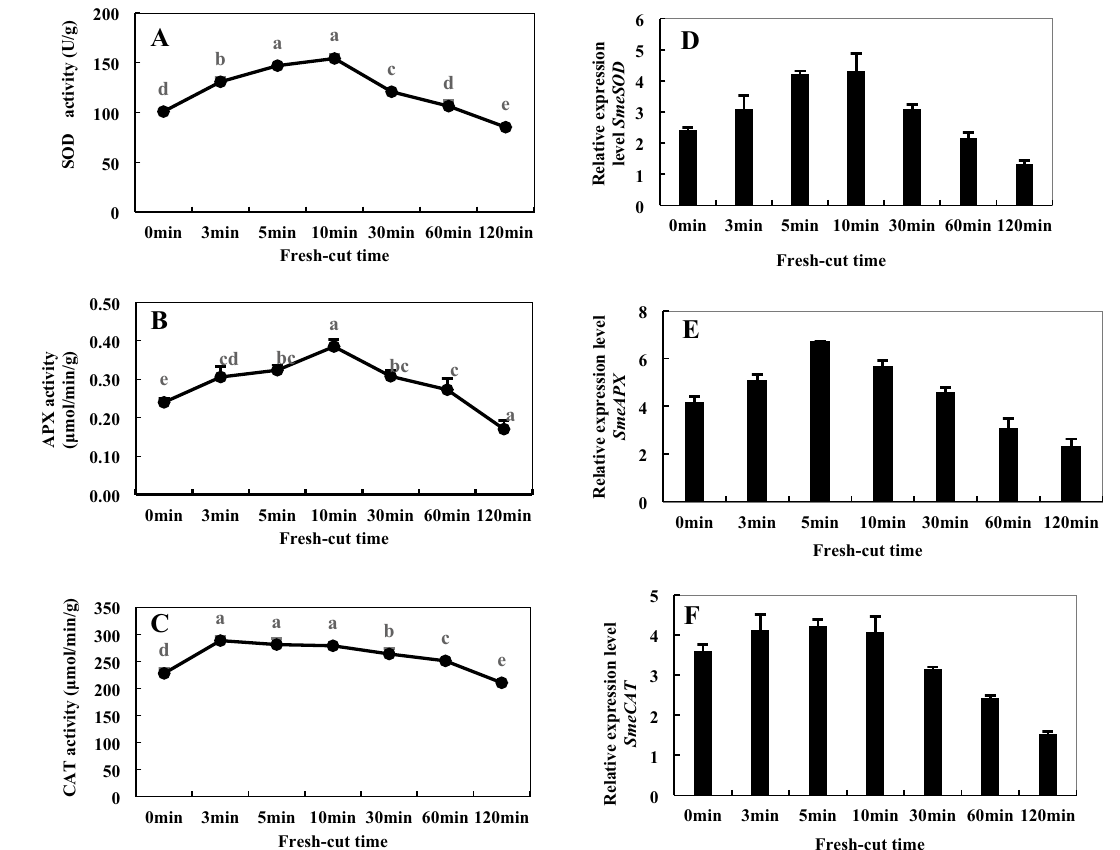
Figure 11. Activities of superoxide dismutase (SOD) ( A ), ascorbate peroxidase (APX) ( B ), and catalase (CAT) ( C ) and gene expression levels of SmeCu/ZnSOD ( D ), SmeAPX ( E ), and SmeCAT ( F ) of fresh-cut eggplant. Data represent the means of three replicates and their standard